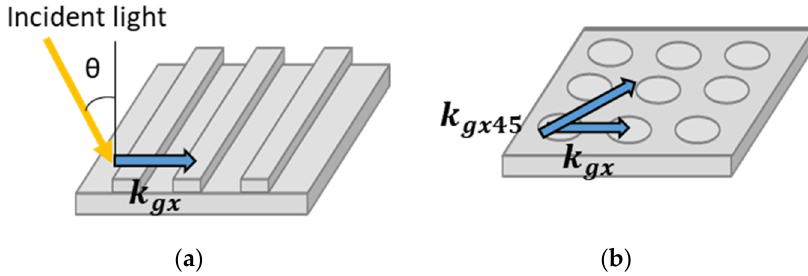
Figure 1. Grating vectors of ( a ) a one-dimensional (1D) plasmonic chip and ( b ) a two-dimensional (2D) plasmonic chip. k gx and k gx 45 are grating vectors coupled with the lateral and diagonal direction of pitch.